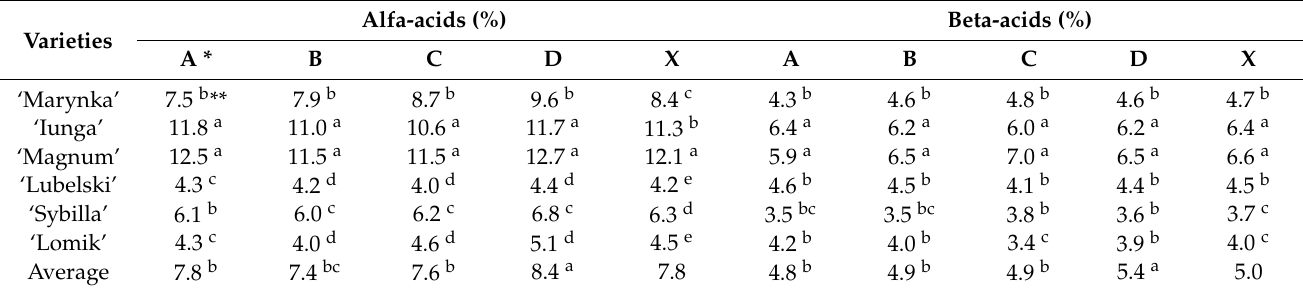
* Designations of localities as in Table 1. ** Letter indicators at the means (significant groups) define the so-called homogeneous (statistically homogeneous) groups. The presence of the same letter index with the means (at least one) means that there is no statistically significant difference between them. The subsequent letter indices a, b, etc., define the groups in ascending order. Table 13. Share of alpha-acids and beta-acids in hop cones depending on the variety and years (Mean for